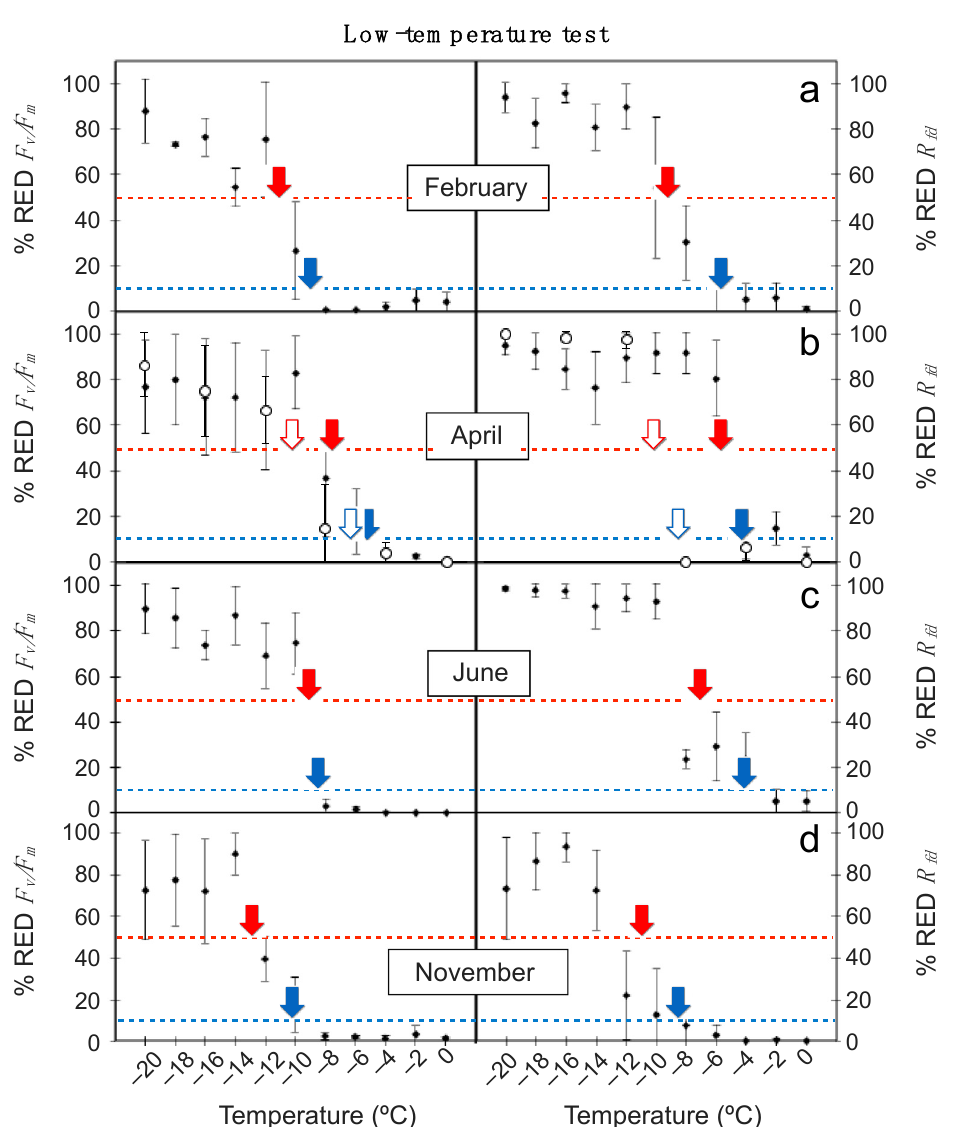
Figure 1. Effect of low temperature treatments on the reduction of F v /F m (% RED F v /F m ) and R fd (% RED R fd ) in mature leaves of E. scoparium along the year (close symbols) and in young leaves (open symbols) in April. Symbols are mean ± SD ( n = 6, except for young leaves where n = 3). Red and blue arrows indicate the LT50 and the LT10, respectively, shown in Table 1. As revealed by Chl a F imaging, low temperature effect was heterogeneous across the leaf blade (Figure 2a). The semi-quantitative analyses of the Chl a F images revealed the coverage of the damaged area (Figure 2b) highlighting the differences across sampling months. Hence, the highest tolerance to freezing occurred in November. This was the only month without an apparent leaf rise in % RED F v /F m at temperatures as low as − 10 ◦ C (Figure